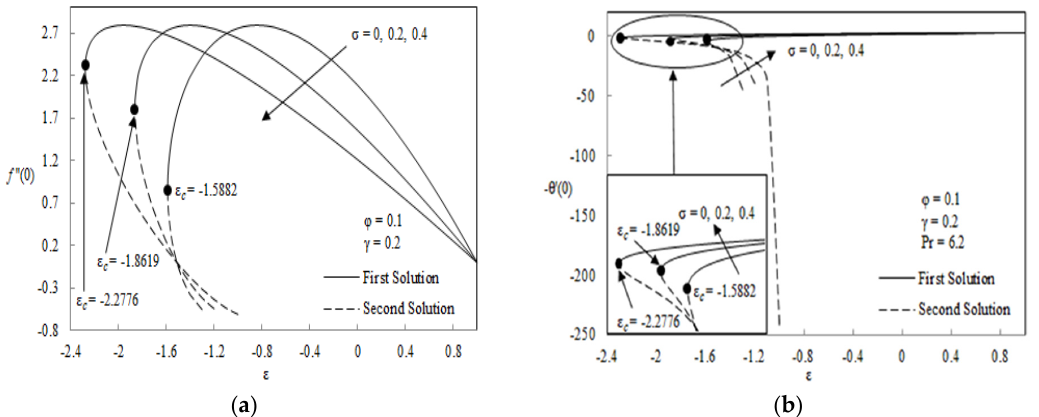
Figure 2. Skin friction f (cid:48)(cid:48) ( 0 ) ( a ) and heat transfer coefficient − θ (cid:48) ( 0 ) ( b ) vs. ε for particular values of σ